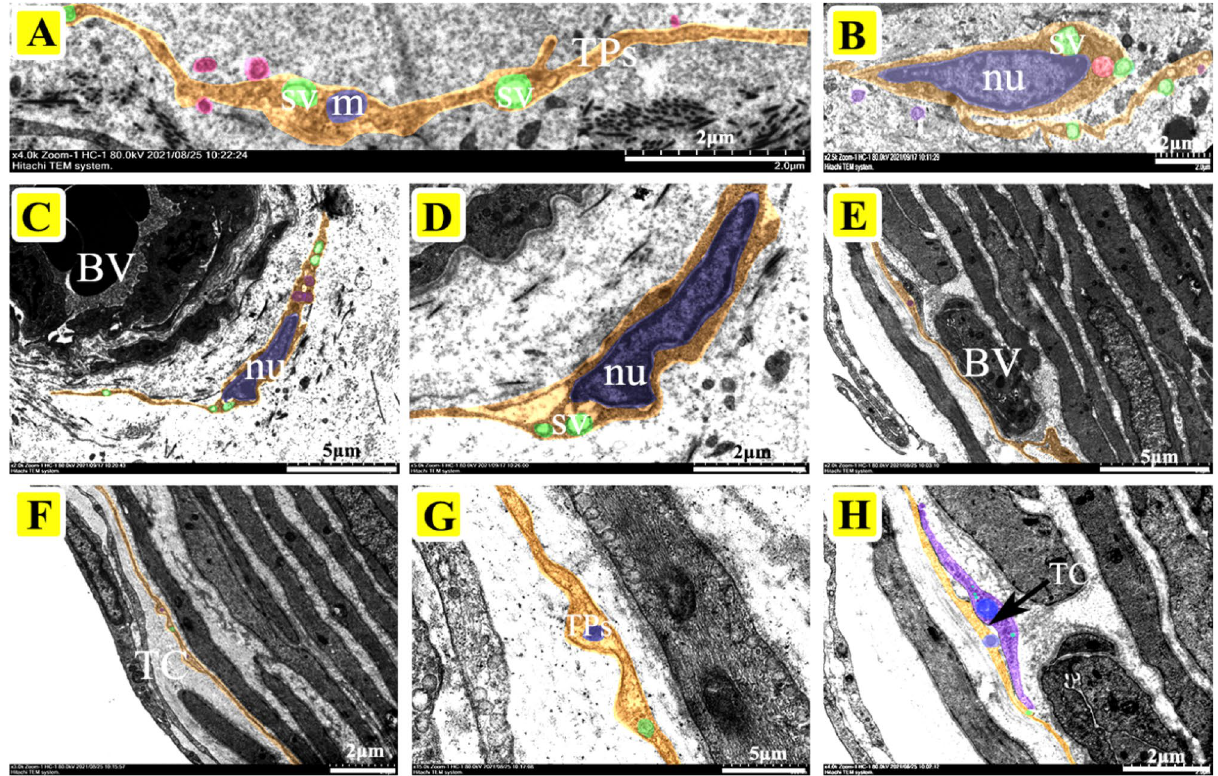
Figure 1. The localization of telocytes in the caput epididymis of yak by TEM. ( A ) Ultrastructure of TPs. The TPs have a long strip- or bead-like structure, which is characterized by the alternating appearance of thick protrusions and slender podomers. There are abundant secretory vesicles and mitochondria in TPs (Scale bar = 2 µm). ( B ) The TCs consist of a large spindle nuclei and a number of secretory vesicles, mitochondria, and lysosomes (Scale bar = 2 µm). ( C , D ) The outline of TCs was clearly visible and distributed around the interstitial capillaries of yak caput, which was composed of spindle-shaped nuclei and long TPs ( C : Scale bar = 5 µm, D : Scale bar = 2 µm). ( E , F ) The TCs located outside the peritubular connective tissue and the TPs connected to the capillary wall to form a special network ( E : Scale bar = 5 µm, F : Scale bar = 5 µm). ( G , H ) The TCs distributed in the intertubular stroma, had slender and coiled TPs that contacted with peritubular myoid cells and fibroblasts ( G : Scale bar = 5 µm, H : Scale bar = 2 µm). BV: blood vessel, nu: nucleus, SV: secretory vesicles, m: